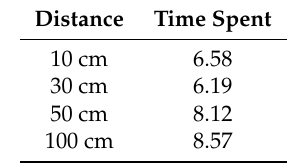
Table 5. Mean time spent (seconds) by Konke’s smart socket before the device recognized the credential